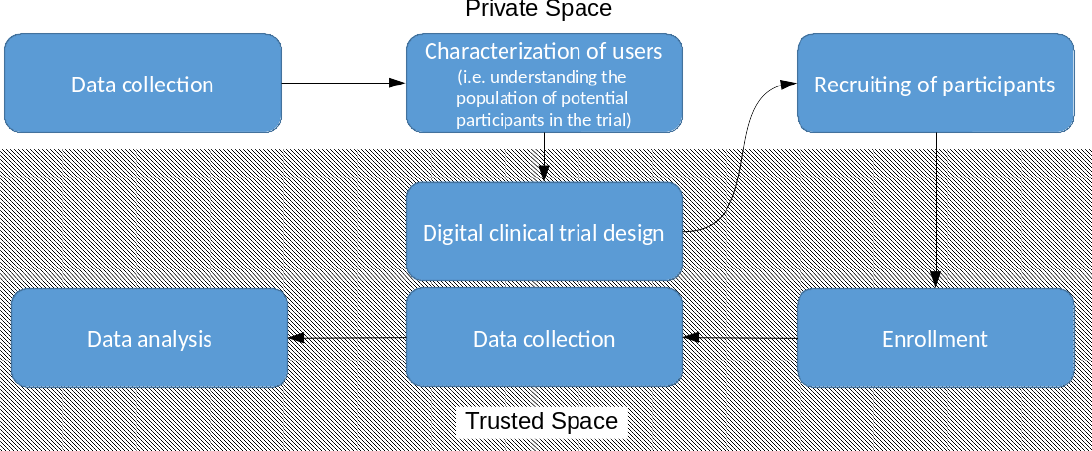
Figure 1. A simplified representation of the main phases for conducting digital clinical